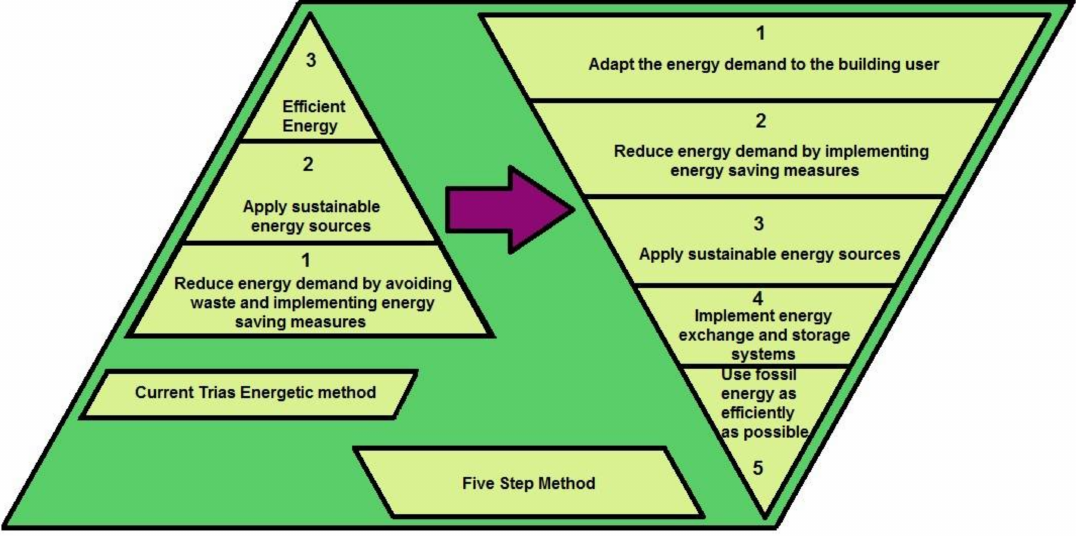
Figure 9. Energy design of a nZEB